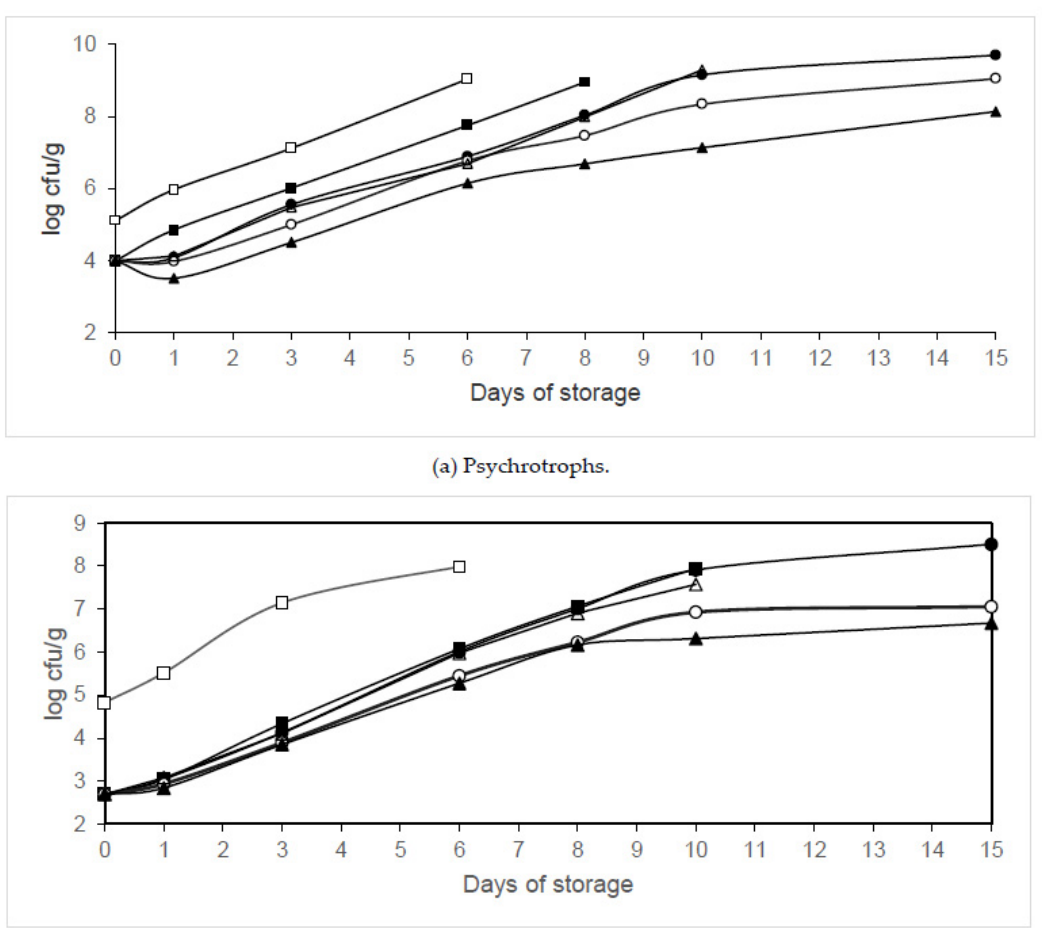
Figure 6. Changes in psychrotroph and L. monocytogenes counts in chicken legs treated with propionic acid and packaged under MAP. Treatment conditions: Batch C, distilled water and packaging in air ( □ ); Batch PA, 2% propionic acid and packaging in air ( ▪ ); Batch PAM20, 2% propionic acid and packaging in 80% N 2 /20% CO 2 ( • ); Batch PAM40, 2% propionic acid and packaging in 60% N 2 /40% CO 2 ( ◦ ); Batch PAM60, 2% propionic acid and packaging in 40% N 2 /60% CO 2 ( ▲ ); Batch PAV, 2% propionic acid and packaging under